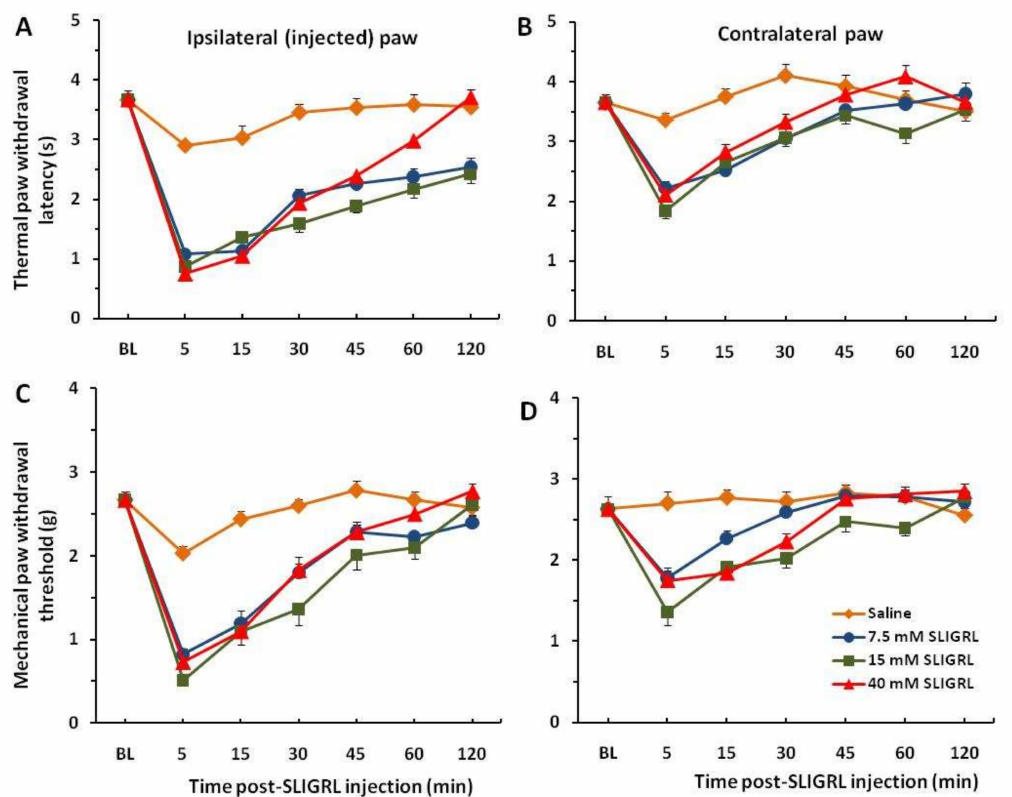
Figure 1. Dynamics of the thermal and mechanical withdrawals. Intra-plantar injection